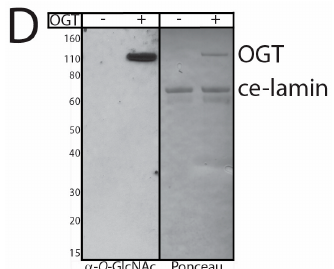
Figure 2. In vitro O -GlcNAcylation of recombinant lamin tails. ( A ) Schematic diagram of the